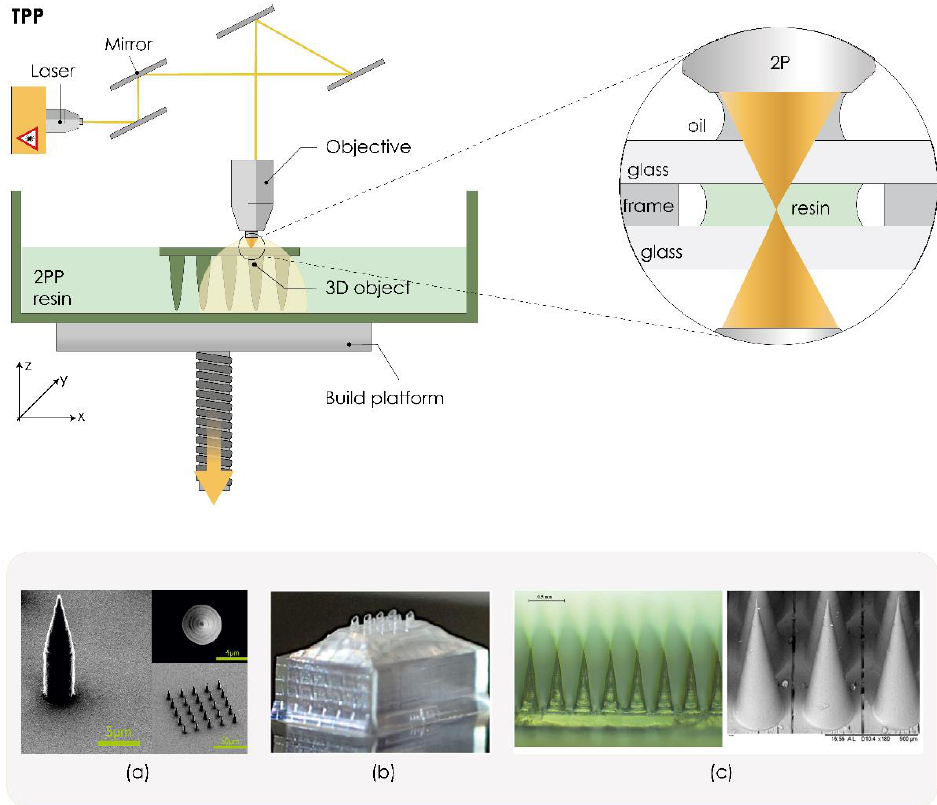
Figure 5. The working principle of two-photon polymerization (TPP) technology. ( a – c ) Microneedles produced by TPP. Reproduced with permission from [17,142,143], IOP Publishing, Ltd., 2020, John Wiley & Sons, Inc, 2017, Springer Nature, 2020. The image was created with Adobe Illustrator CC (Version 23.0.1.; Adobe Inc., San Jose, CA, USA, 2019).